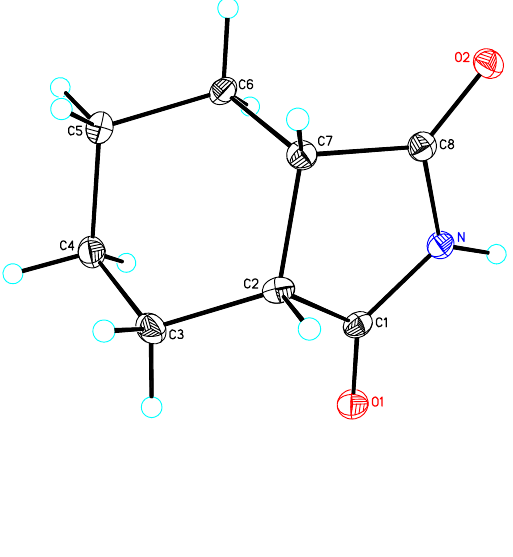
Figure 1 . Molecular Diagram of 3a,4,5,6,7,7a-Hexahydro-1H-isoindole-1,3(2H)-dione ( 4 )